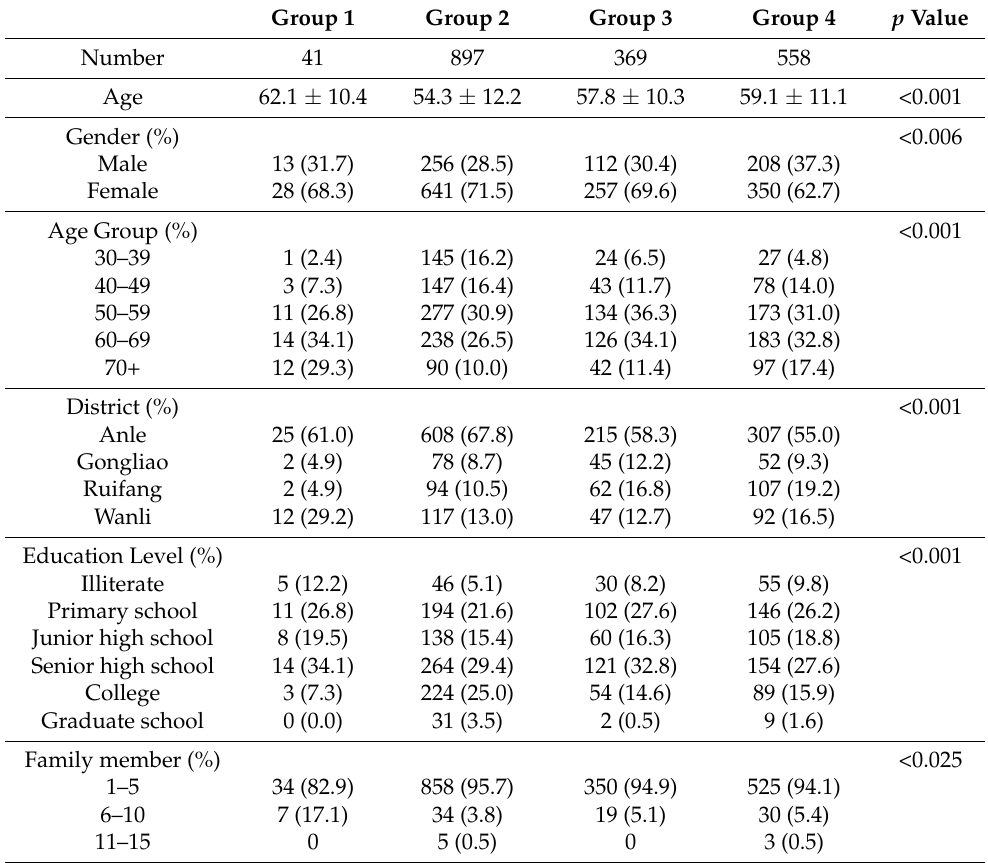
Table 1. Demography.